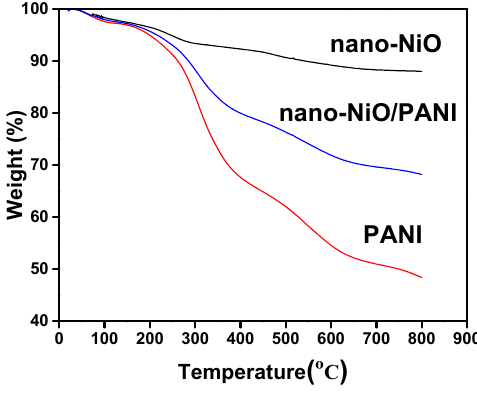
Figure 5. TGA analysis of PANI and PANI/nano-NiO.